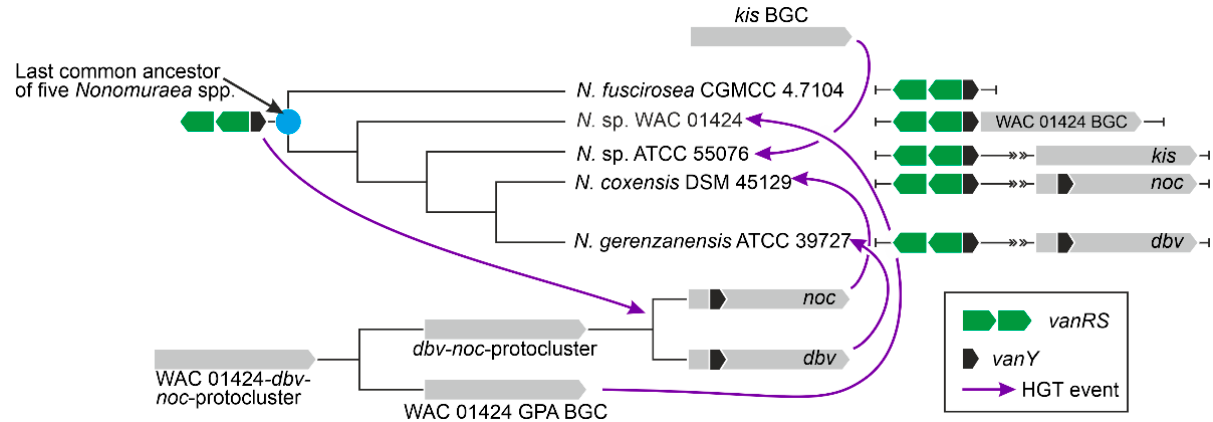
Figure 12. Scheme for the discussed scenario for vanY -like genes and GPA BGCs co-evolution in Nonomuraea spp. Please refer to the main text for more details.